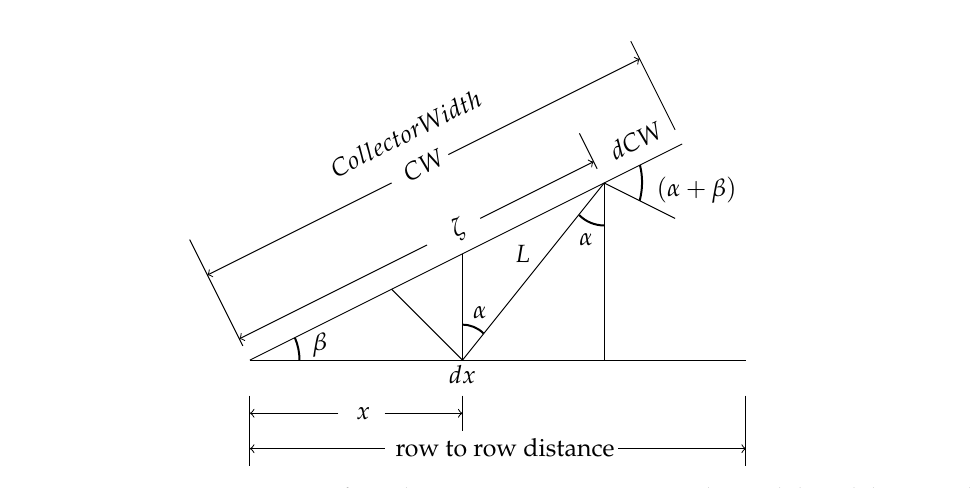
Figure 2. View factor between two segments on a solar module and the ground. α is the cosine of the angle between the normal of the ground surface and the vector connecting the ground and module segments under analysis. d α is the angle subtended